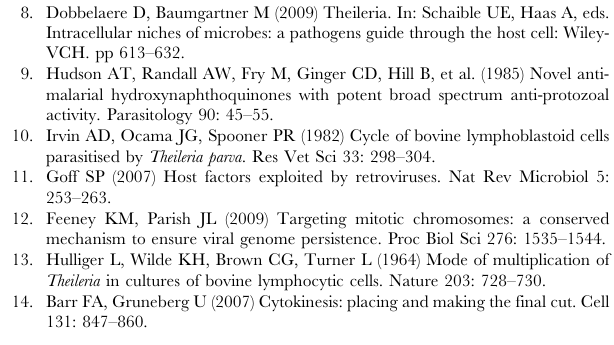
the specific inhibitor RO-3306 (30 min). The formation of central spindles was monitored using anti- a -tubulin and anti-Plk1. The parasite was visualized using anti-TaSP1. Scale bar represents Figure S10 The Theileria schizont recruits central spindles to its surface. T. annulata -transformed cells were synchronized in prometaphase and precocious anaphase induced by blocking Cdk1 using the inhibitor RO-3306. Cleavage furrow contraction was prevented by treatment with the myosin II inhibitor blebbistatin. Parasite-associated central spindles were analyzed for the presence of central spindle-specific proteins such as Plk1, Aurora B, Cyk-4, and PRC1 as indicated. MTs were visualized using anti- a -tubulin, and the schizont was stained using anti-TaSP1; in the lower panels, DNA was stained with DAPI. Arrowhead indicates the position of the parasite. Scale bar represents 5 m m. Figure S11 Recruitment of central spindle, but not astral, MTs to the parasite surface requires catalytically active Plk1. (A) T. annulata -transformed TaC12 cells were released for 80 min from metaphase arrest in the presence of the Plk1 inhibitor BTO-1 or control solvent. Cleavage furrow contraction was blocked by treatment with the myosin II inhibitor blebbistatin. Anti- a -tubulin was used to identify central spindles and parasite-associated MTs emanating from the spindle poles. Open arrowheads point at Plk1 binding to the schizont surface; closed arrowheads indicate central spindles lacking Plk1 in the central section. (B) Representative micrographs of IFM stainings that were used to quantitate the association of the parasite with central spindles in control cells and cells treated with Plk1 inhibitors (histogram Figure 9C). Cells were stained for the central